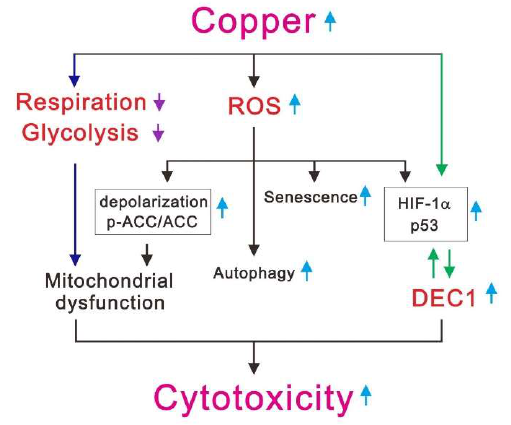
Figure 8. E ff ects of copper sulfate are cell-type specific. HeLa, HEC-1A, HEK293, A549, and Beas-2 cells were incubated for 8 h with the indicated concentrations of copper sulfate. Cell lysates were then subjected to western blot analysis using antibodies against HIF-1 α , p53, and DEC1. HuR served as the protein loading control. The results are representative of three independent experiments. Protein bands were quantified through pixel density scanning and evaluated using ImageJ, version 1.44a (http: // imagej.nih.gov / ij / ). The fold (shown above the bands) was normalized to the internal control (HuR).